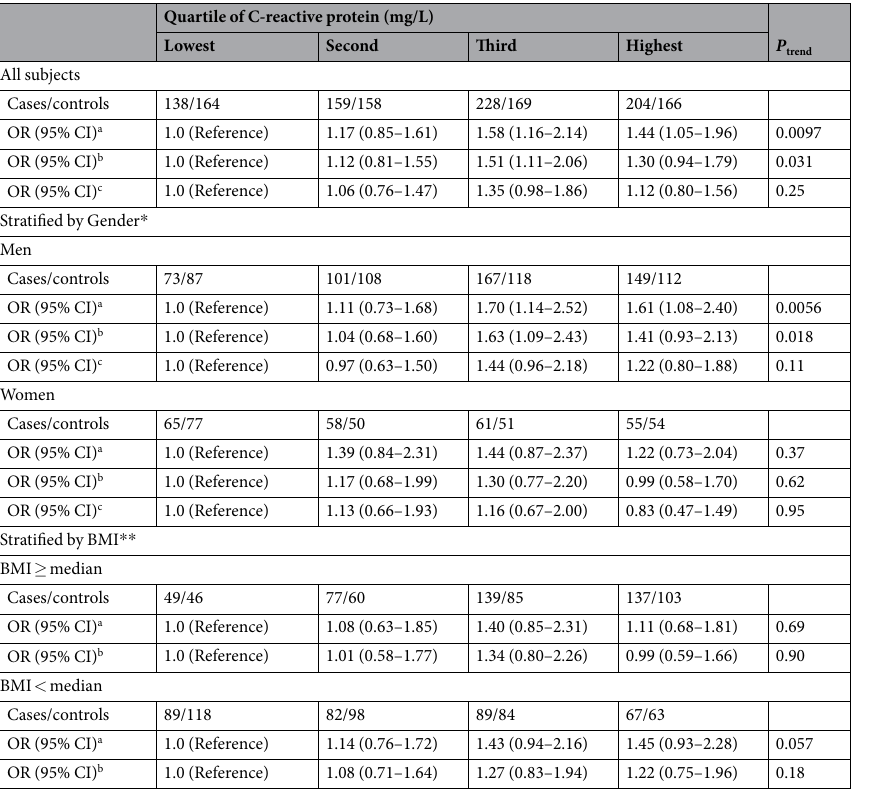
Table 3. Association of C-reactive protein with colorectal adenoma, by gender and BMI. a Adjusted for age (40–49, 50–54, 55–59, 60–64, ≥ 65 years), sex (except when stratified by gender), and screening period. b Further adjusted for family colorectal cancer history, pack-years of smoking (never, ≤ 20, 21–40, > 40 pack-years), alcohol drinking (never, past, < 150, 150–299, ≥ 300 g per week), physical activity (METs-hour/day, quartile), and history of diabetes mellitus. c Further adjusted for body mass index (BMI) ( < 21.0, 21.0–22.9, 23.0–24.9, and ≥ 25.0 kg/m 2 ). * Interaction for sex was not significant (P = 0.281). ** Interaction for BMI was not significant (P =